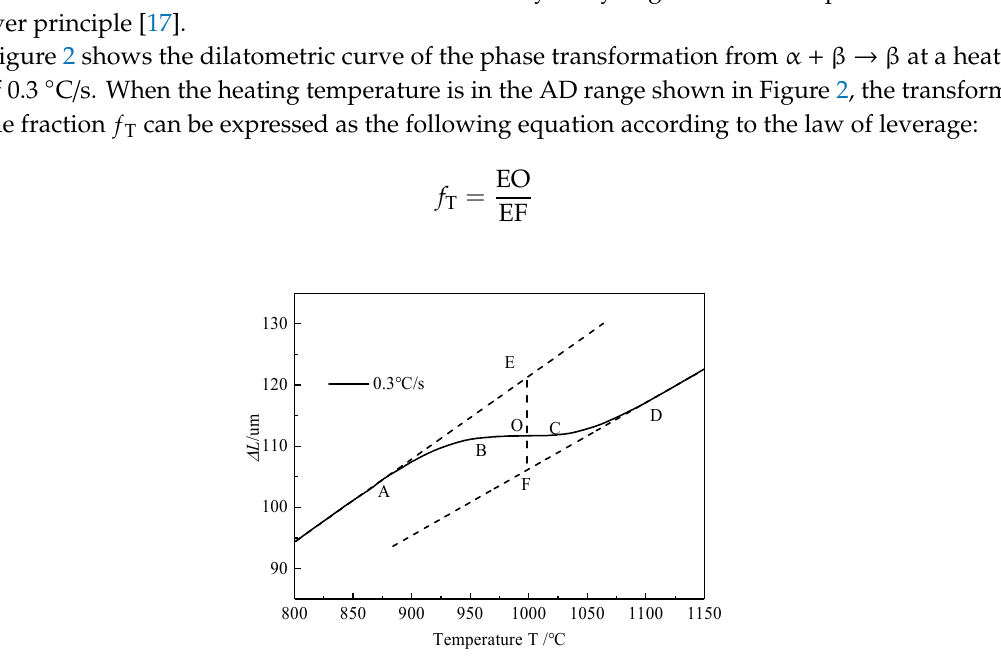
Figure 2. Dilatometric curve during heating process at a heating rate of 0.3 °C/s.